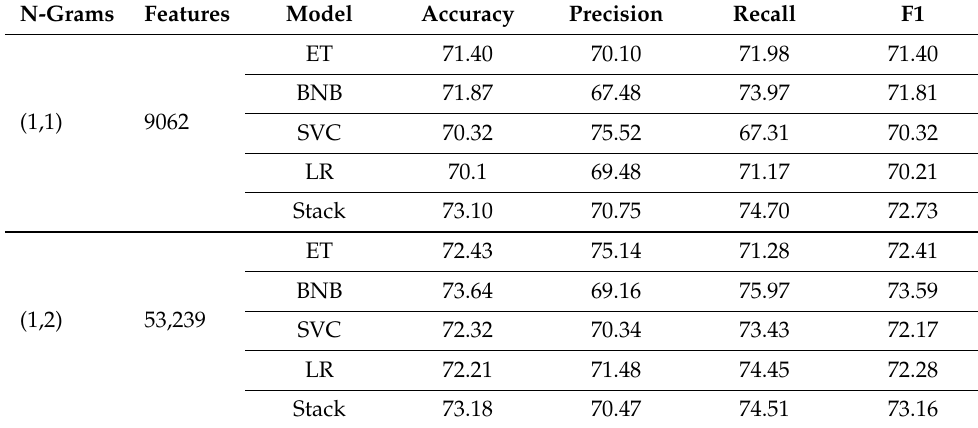
Table 8. Threatening language detection using uni-gram BoW features.